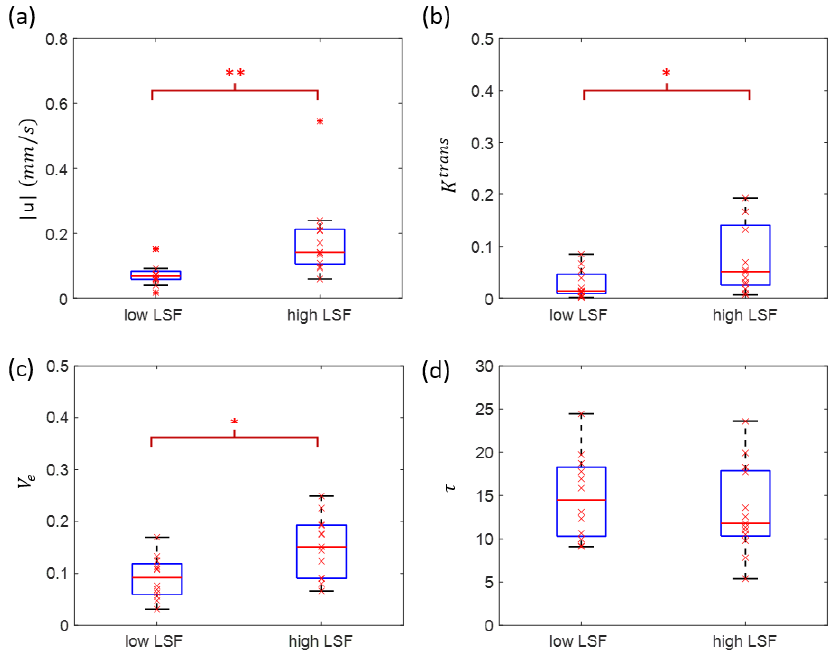
Figure 4. Mann – Whitney U test of QTM |𝒖| ( a ), 𝐾 𝑡𝑟𝑎𝑛𝑠 ( b ), 𝑉 𝑒 ( c ), 𝜏 ( d ) between low-risk subjects (lung shunting fraction ≤ 10% ) and high-risk subjects (lung shunting fraction > 10% ). (LSF: lung shunting fraction; *: p < 0.05; **: p < 0.01).